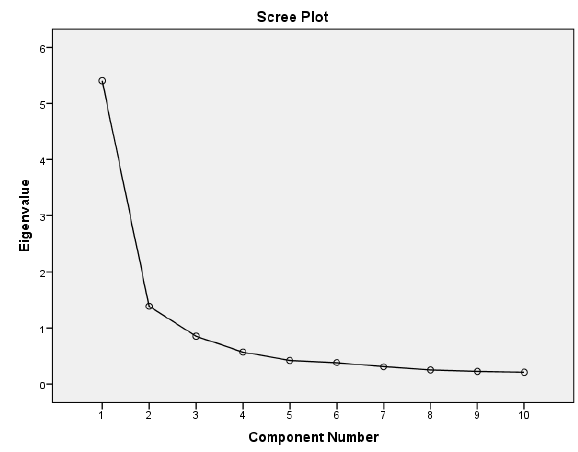
Figure 1: Scree Plot of